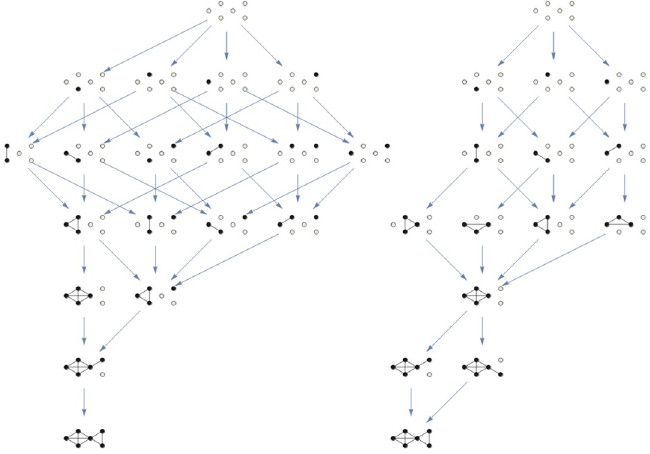
Fig 7. Two different information structures for a six dimensional cooperative LV system, associated to the same cooperative values between nodes (same adjacency matrix) and with different values of the intrinsic parameter α Note that both structures have the same kind of globally asymptotically stationary point, the one with the six components strictly positive. However, these structures produce a very different phase space deformation (information field) in both cases. Indeed, all the transient behaviour of every solution will follow the metastability imposed by the structure. These complex graphs are just two of the many that coexist within the cone of maximal biodiversity that describes the structural stability in the sense of [39] for this